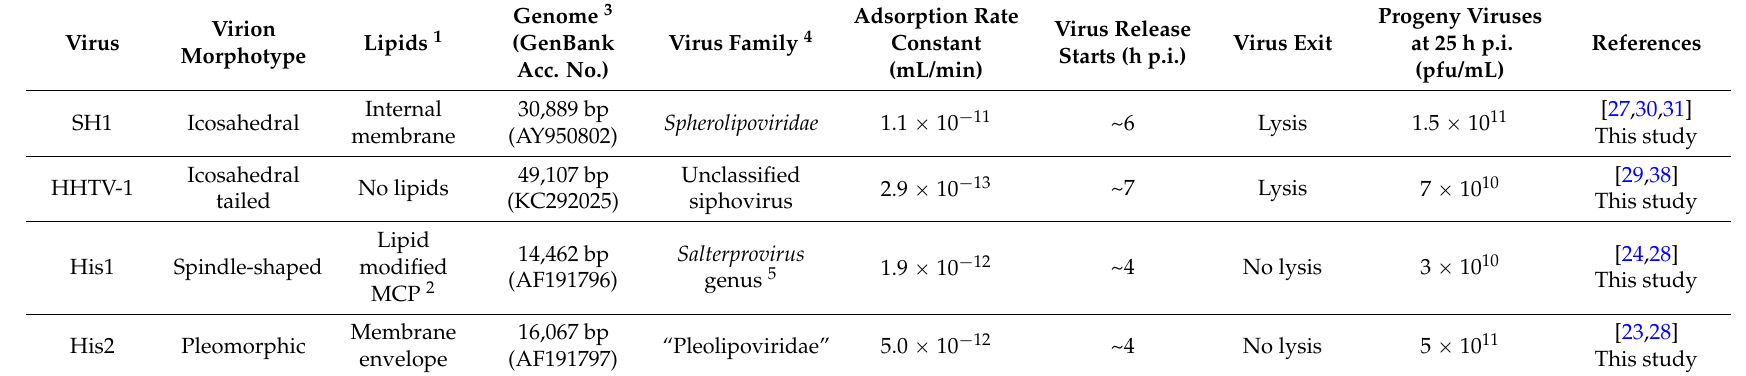
Table 1. Haloarcula hispanica SH1, HHTV-1, His1, and His2 viruses used in the study: virion and virus life cycle